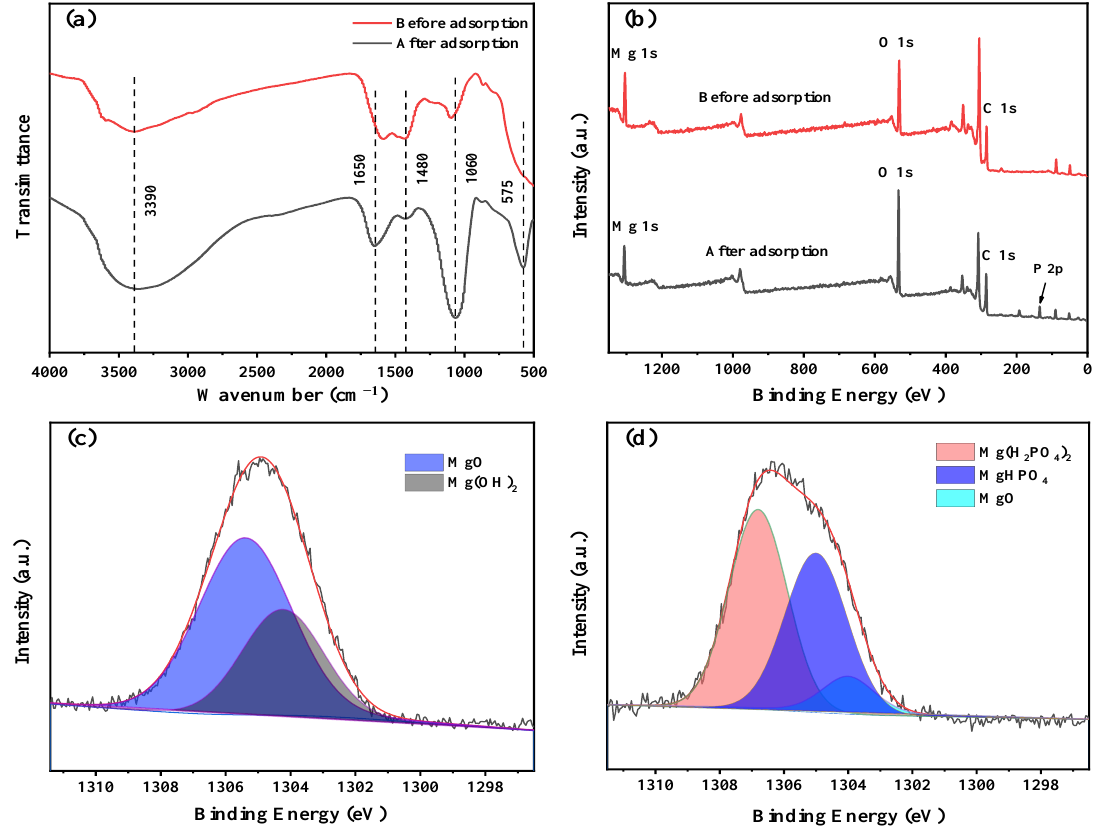
Figure 6. FTIR spectra ( a ) and XPS full-scan spectra ( b ) of 2MgO/BC-450-0.5 before and after adsorption. XPS spectra of Mg 1s before ( c ) and after ( d ) adsorption of 2MgO/BC-450-0.5.